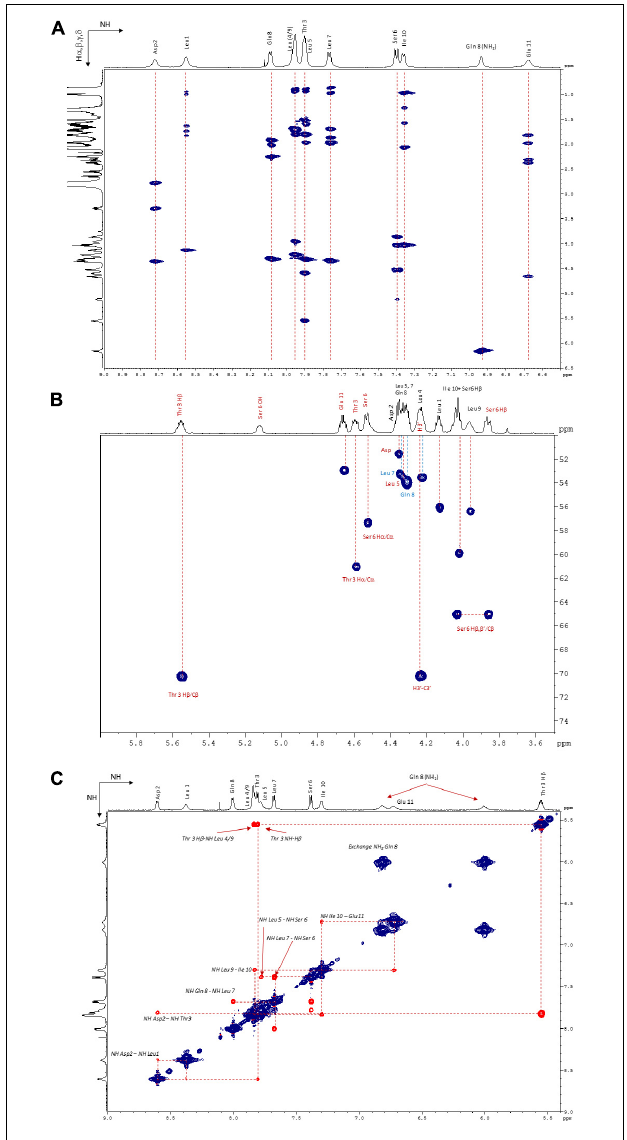
FIGURE 6 | (A) NH/H α , β , and γ zone of the 1 H– 1 H TOCSY NMR spectrum (600 MHz, 298 K, Acetone-d 6 ). (B) H α /C α zone of the 1 H– 13 C HSQC NMR spectrum (600 MHz, 298 K, Acetone-d 6 ). (C) NH/NH zone of the 1 H– 1 H NOESY NMR spectrum (600 MHz, 323 K, Acetone-d 6 ).